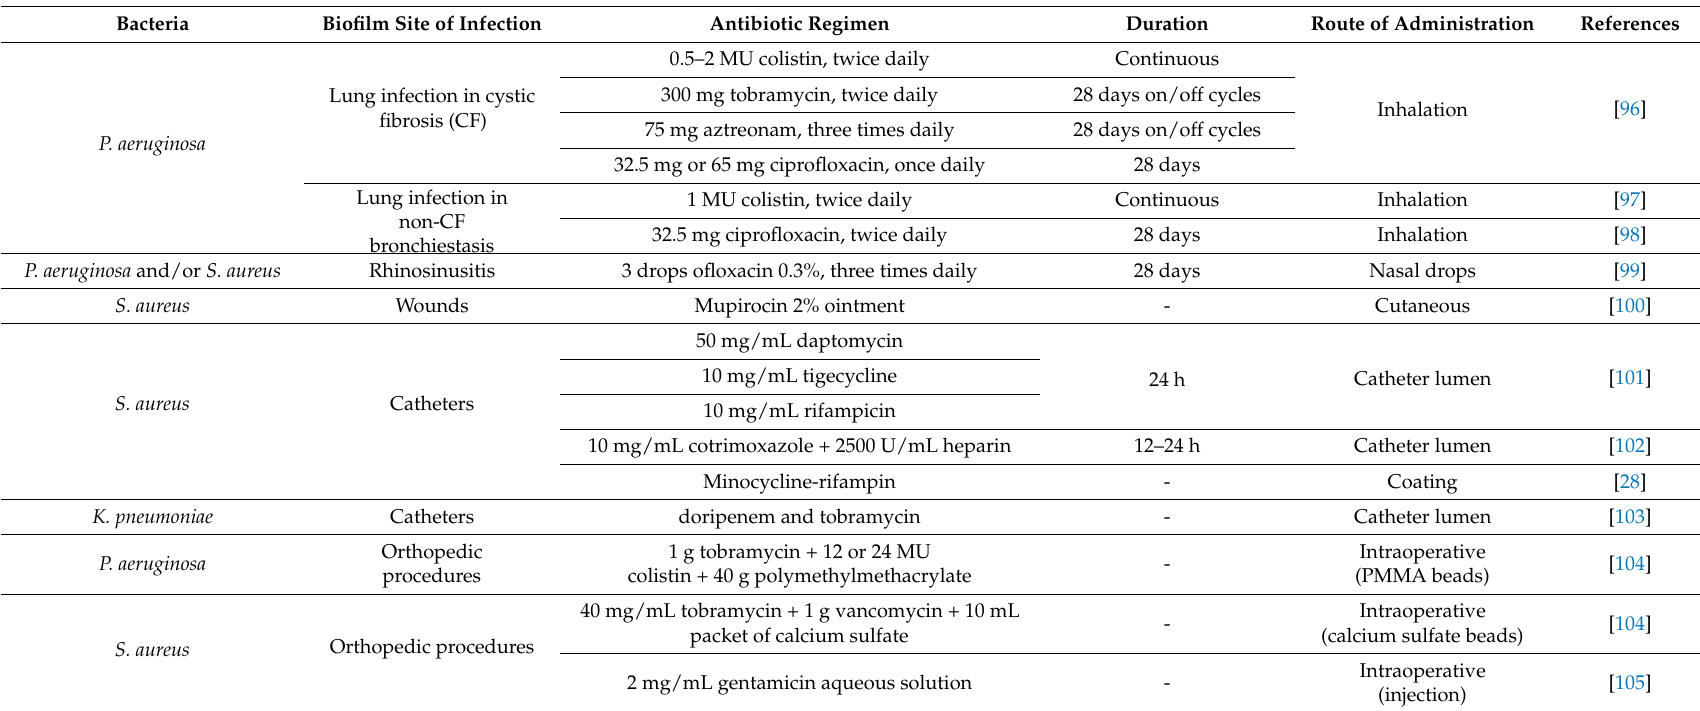
Table 4. Summary of existing antibiotic regimens according to the specific microbial